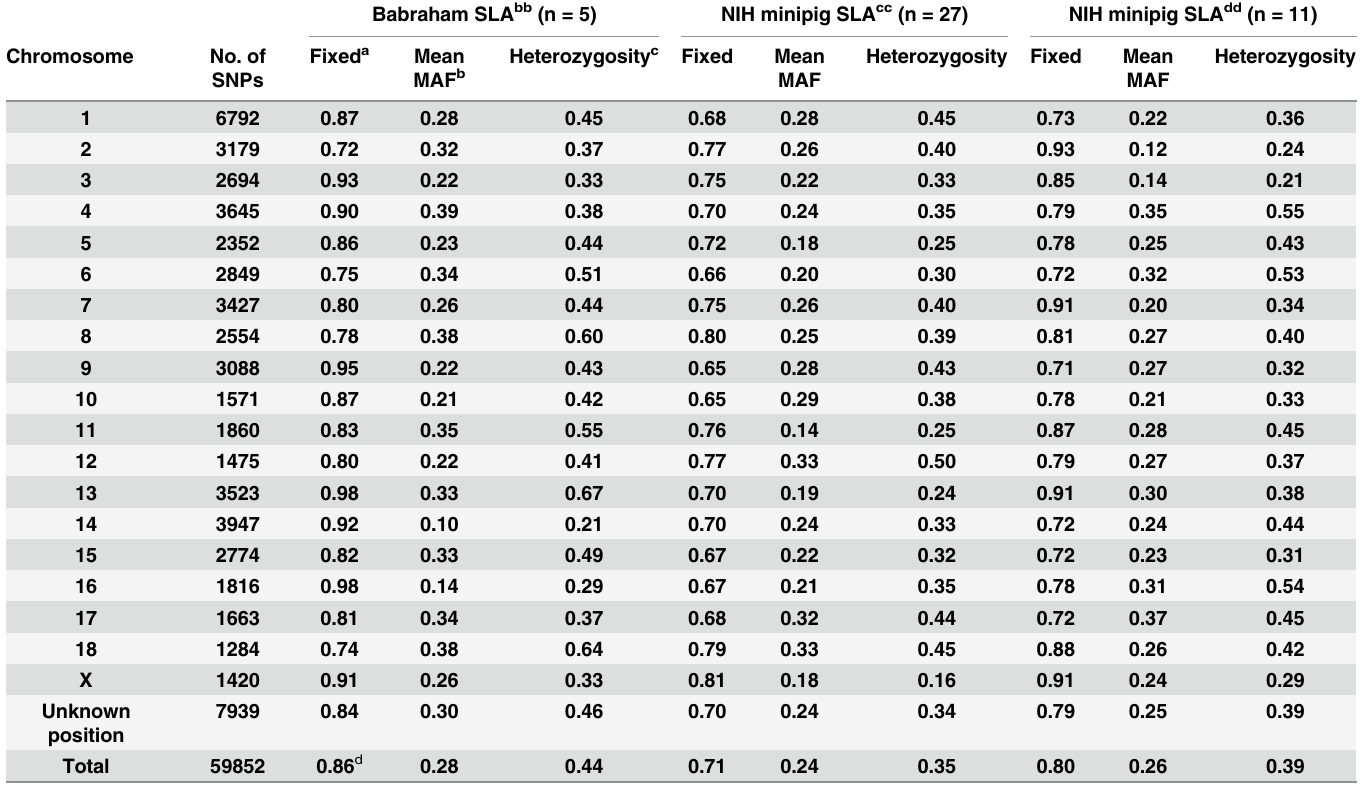
Table 1. Heterozygosity of SNPs on individual chromosomes of SLA bb , SLA cc and SLA dd lines of